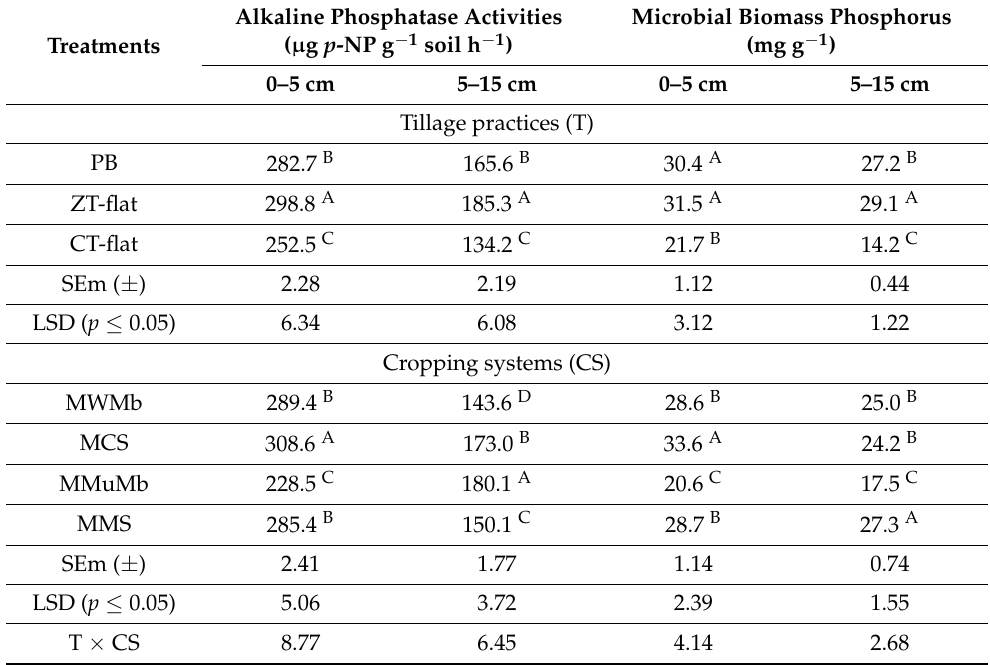
Table 5. Long-term impact of different tillage practices and maize-based crop rotation on alkaline phosphatase activities ( µ g p-NP g − 1 soil h − 1 ) and microbial biomass phosphorus (mg g − 1 ) at different soil